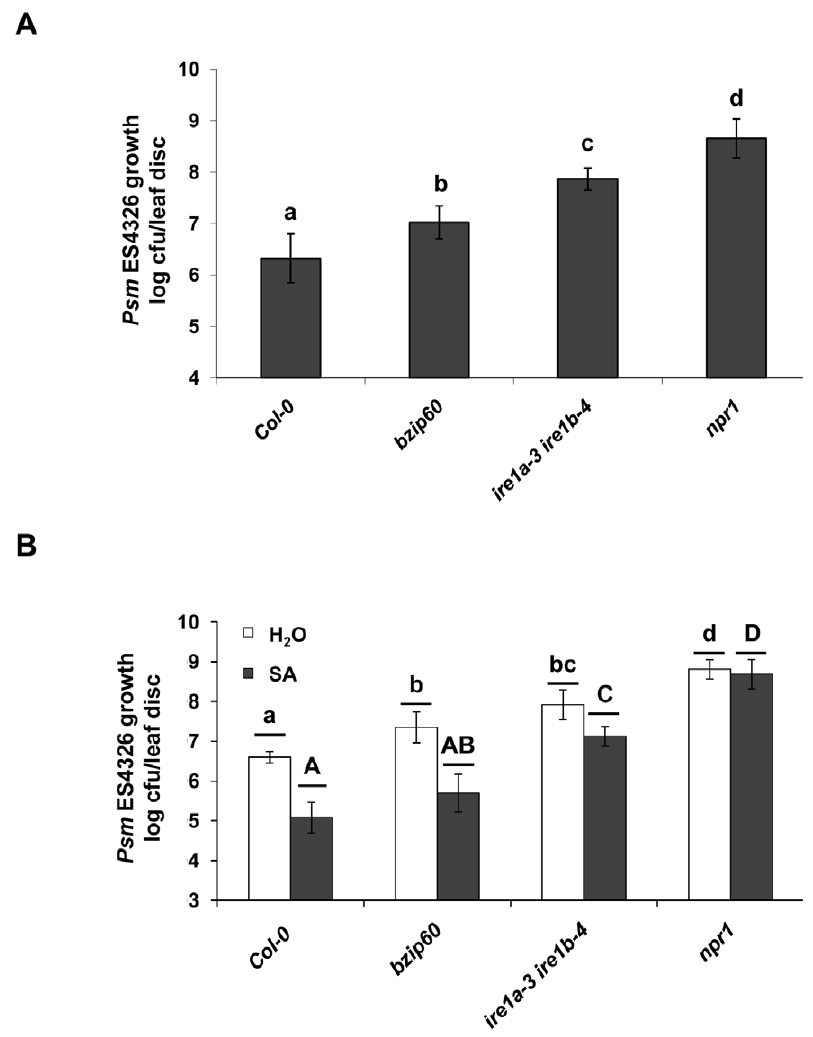
Figure 8. bZIP60 is involved in plant defense. A, Col-0, bzip60 , ire1a-3 ire1b-4 and hypersusceptible npr1 mutant were infected with Psm ES4326 (OD=0.0002). Bacterial growth (colony forming units – cfu/leaf disc, expressed on a log scale) was quantified in the leaves of indicated genotypes at 3 dpi. Error bars represent 95% confidence intervals of the mean ( n =8). Bars connected by the same letter did not differ from each other at p , 0.05 (Tukey’s HSD tests). B, Chemical SAR was established by treating Col-0, bzip60 , ire1a-3 ire1b-4 and hypersusceptible npr1 mutant with 1 mM SA or mock (water) 16 hours prior to Psm ES4326 (OD=0.001) infection. Bacterial growth was monitored 3 days post inoculation. Error bars represent 95% confidence intervals of the mean ( n =8). Bars within a class connected by the same letter (lowercase for water treatment; uppercase for SA treatment) did not differ from each other at p , 0.05 (Tukey’s HSD tests). All the experiments were performed at least three times with similar results.